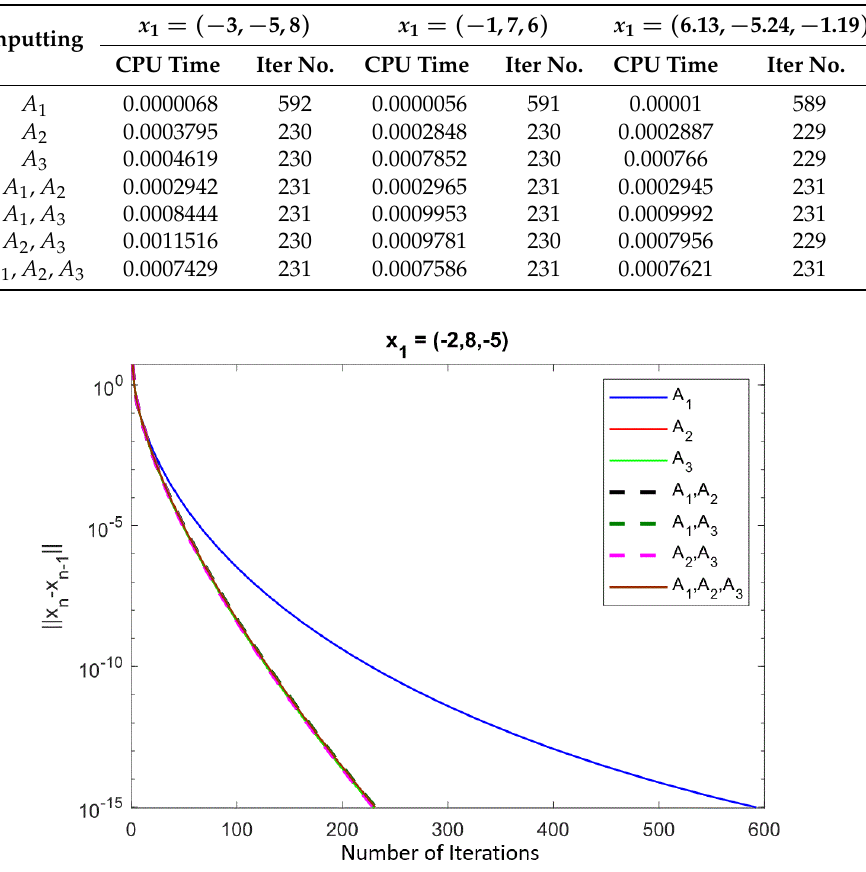
Figure 1. The error plotting (cid:107) x n − x n − 1 (cid:107) for choice 1 in Example